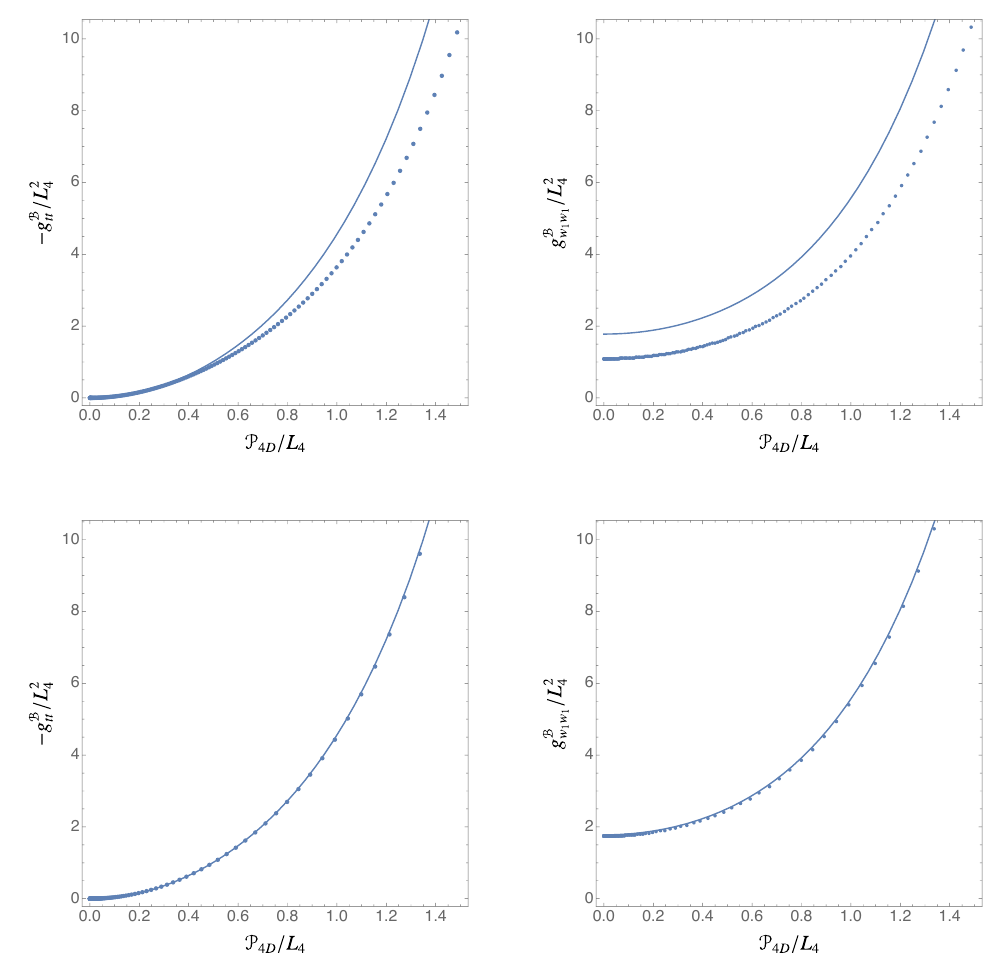
/ L 2 / L 2 Figure 3: Plots of − g and g on the RS brane (located at x = 0) as a tt w 1 w 1 4 4 function of the proper distance from the horizon P . In the top row, θ ≈ 1.47113, 4 D and in the bottom row, θ ≈ 0.343024. The blue disks correspond to the numerical data, and the solid blue lines are obtained from the 4d planar AdS black hole geom- etry. It is clear that as θ becomes smaller, the induced geometry on the brane gets closer to that of a 4d planar AdS black